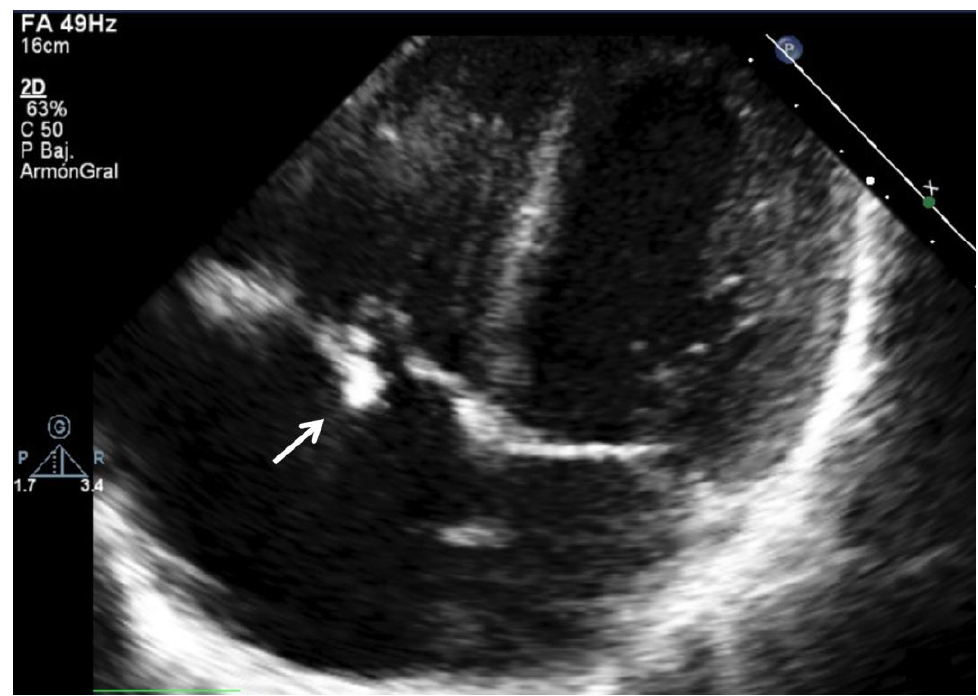
Figure 3. A 16-year-old male with native tricuspid valve infective endocarditis due to Viridans Streptococcus. Previous history of CHD with restrictive perimembranous ventricular septal defect, secondary moderate – severe tricuspid regurgitation, and septic pulmonary embolisms.